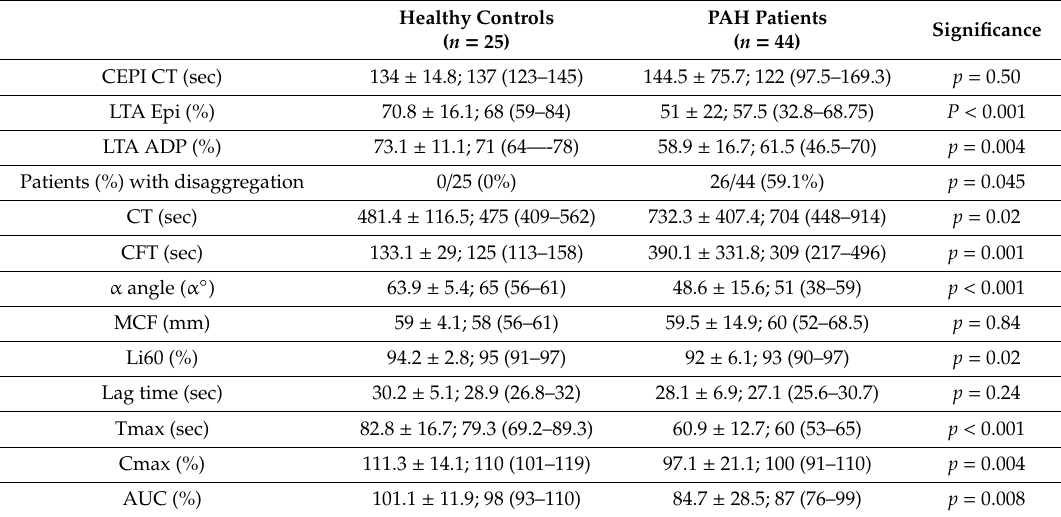
Table 4. Coagulation parameters in patients with pulmonary arterial hypertension and healthy